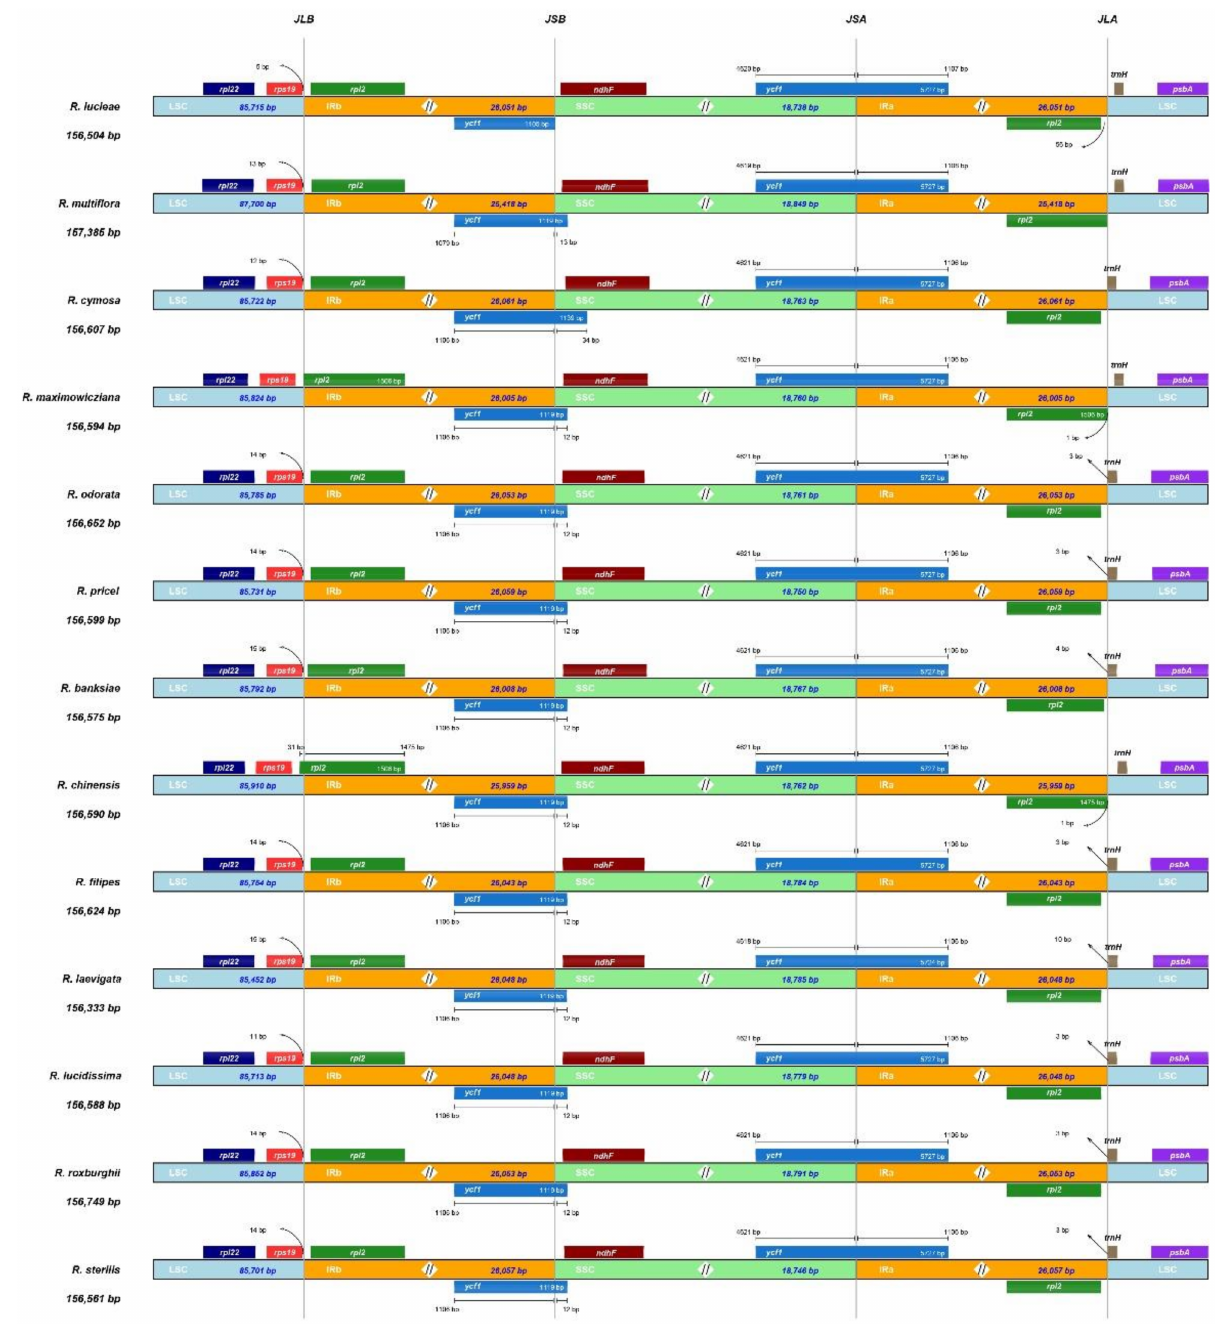
Figure 4. IR/SC boundary contraction and expansion of chloroplast genomes of 13 Rosa